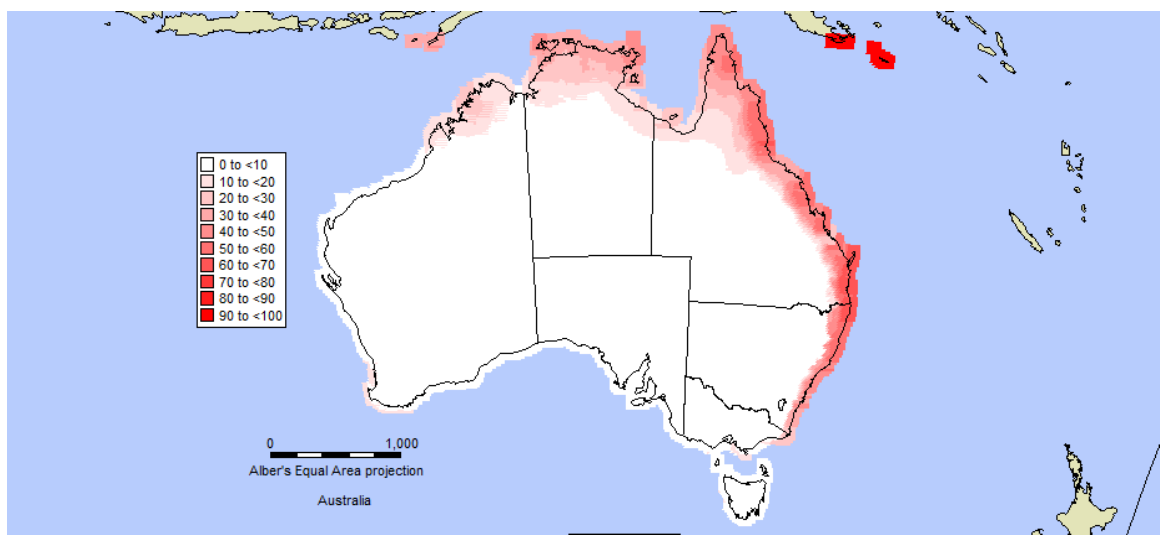
Figure 5. The potential distribution of Cyperus aromaticus in Australia as predicted by the CLIMEX model.